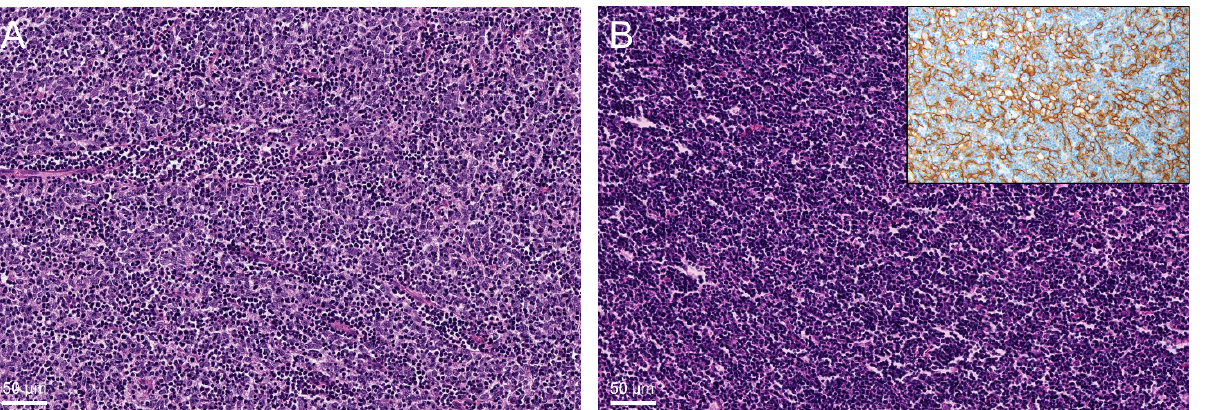
Figure 3. ( A ) “Conventional B2-thymoma” with clusters of neoplastic epithelial cells with vesicular nuclei and distinct nucleoli among numerous lymphocytes (hematoxylin and eosin staining). ( B ) “B1-like” B2-thymoma: While CK19 immunohistochemistry shows a dense epithelial cell network (inlay) not compatible with B1-thymoma, the tumor consists predominantly of lymphocytes with inconspicuous epithelial cells; also note the absence of ‘medullary islands’ which would be required for the diagnosis of B1-thymoma (hematoxylin and eosin